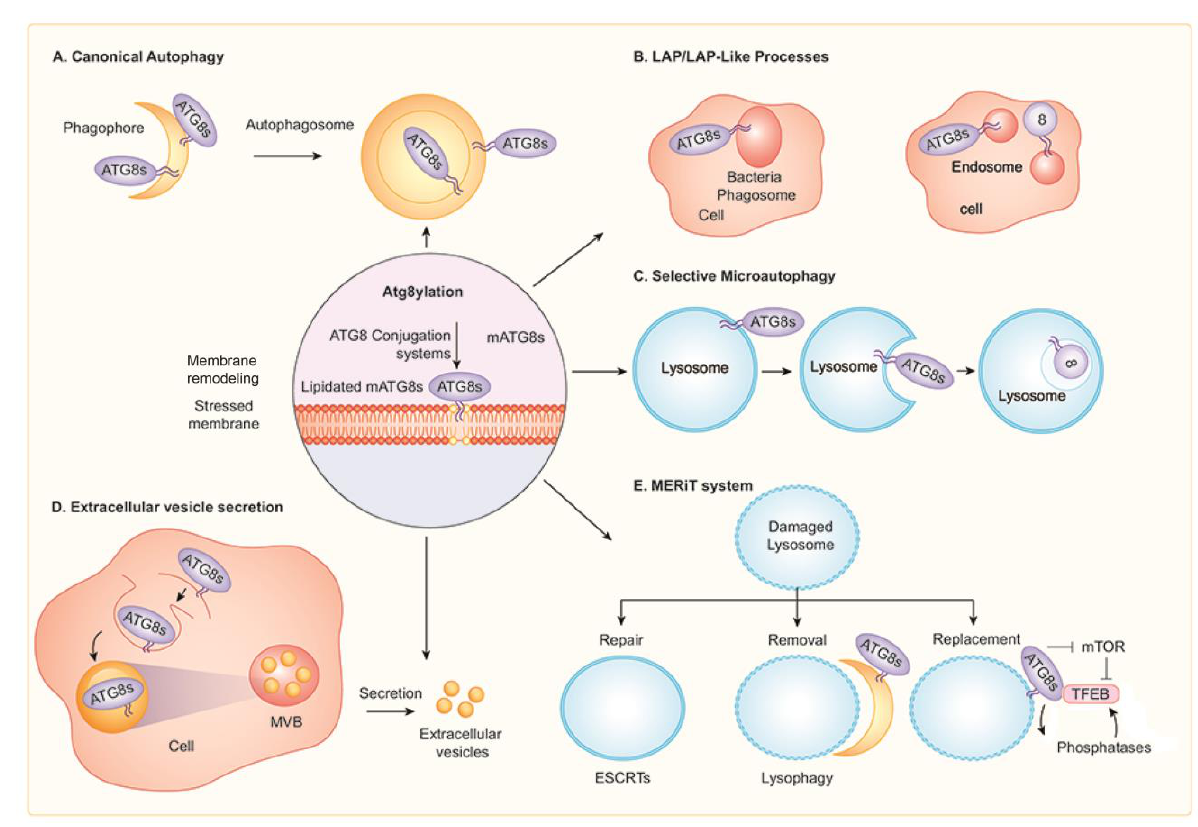
FIGURE 3: Different forms and roles of Atg8ylation. (A) Canonical autophagy. Note double membranes, as phagophores close around the autophagic cargo, and presence of lipidated mAtg8s on the outside and inside of the double membrane autophagosome, however, always on the originally cytofacial leaflet. This is the well-established macroautophagy pathway. (B) LAP and LAP-like processes (Lapoid) occurs on phagosomes and endosomes whose cytofacial leaflet of (single membrane) delimiting the organelles is Atg8ylated upon ecountering physical stress signals. (C) Selective microautophagy occurs via an MVB generation-like process whereby lysosomal delimiting membrane that is Atg8ylated invaginates and reduces the surface, size, and contents of the lysosomes. (D) Extracellular vesicle secretion is a subset of secreto- ry autophagy, and in principle represents similar topological changes (albeit differing in details and regulatory processes involved) as in se- lective microautophagy, except that the cargo sequestered into the MVB-like bodies is secreted upon exocytosis instead of being degraded. Note that EV secretion is a component of a broader collection of secretory autophagy modalities (not shown). (E) MERiT system involves a coordinated response to lysosomal damage, with ESCRTs conducting the repair of mildly damaged lysosomes, autophagy (‘lysophagy’) re- moving extensively damaged lysosomes, and TFEB initiating a lysosomal replenishment program. Note that Atg8ylation thus far has been demonstrated to play a role in the lysophagy and TFEB- dependent steps. See details in the text for each type of Atg8ylation’s manifestations including mechanisms and physiological roles. All events are intracellular, even when cells are not